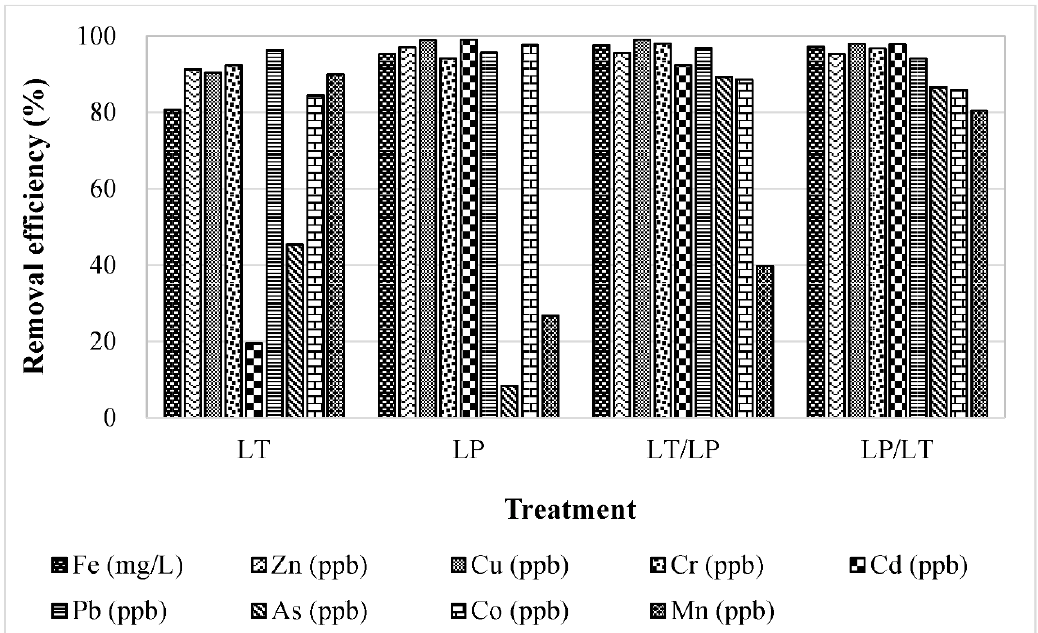
ffi ciencies for the heavy metals in the four treatment Figure 2. Removal efficiencies for the heavy metals in the four treatment applications . Figure 2. Removal e